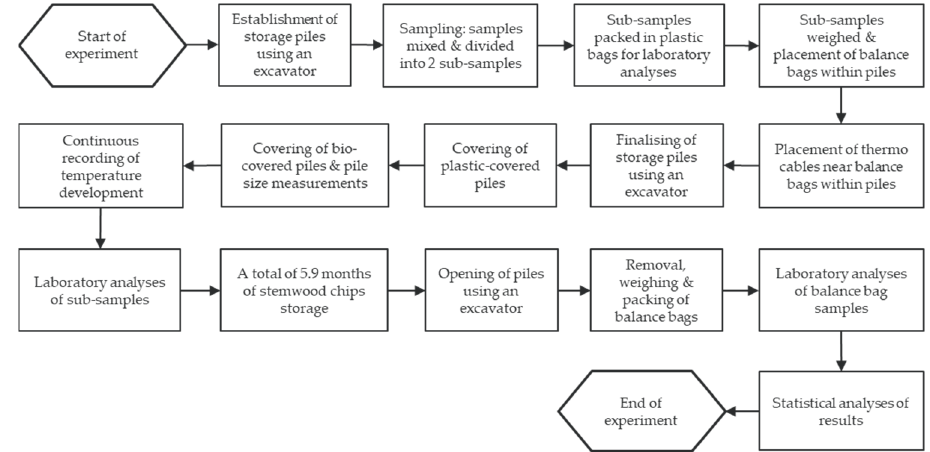
Figure 3. Flowchart of the experiment indicating the chronological steps of the study.